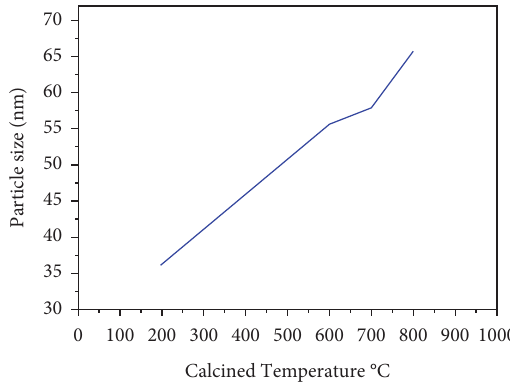
Figure 6: Variation of particle size ( D ) with calcination x )